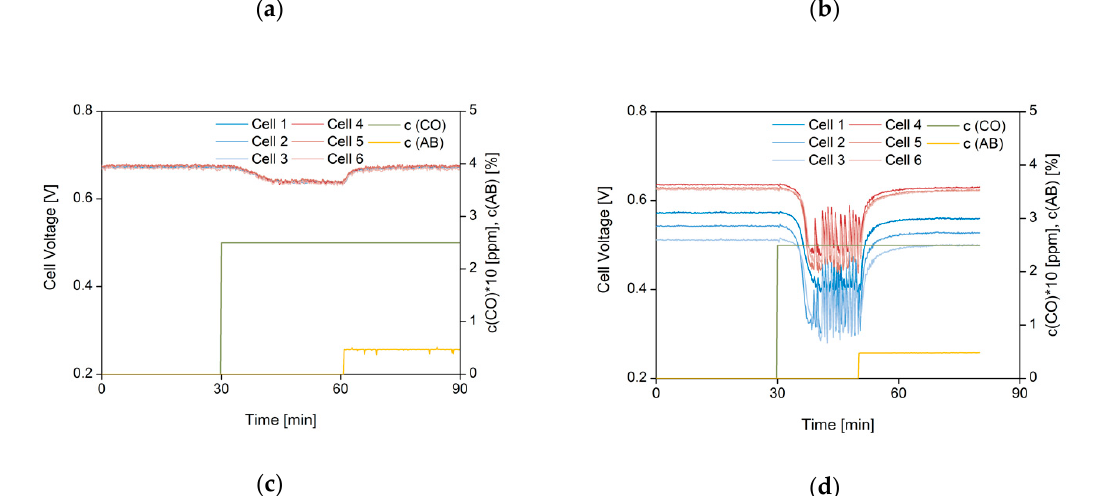
Table 1. Summary of Average Cell Voltage Loss of Stack 01 and Stack 02 at Different CO Concentrations.